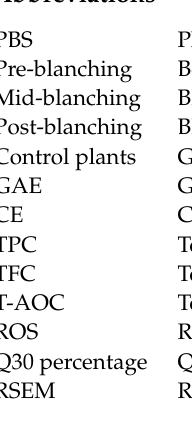
3 data sets; Figure S2: Functional annotations of DEGs against public databases; Table S1: Summary of mapping transcriptome reads to the reference sequence and transcriptomic assembly; Table S2: Differentially expressed genes in control and blanched samples; Table S3: KEGG pathways; Table S4; Targeted pathways and their corresponding